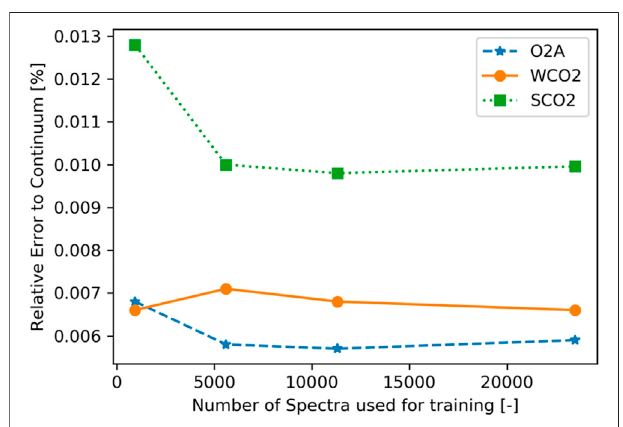
FIGURE11 | Modeling error inpercentrelative tocontinuum fordifferent training set sizes. O2A-band is shown with blue stars, WCO2-band with orange dots, and SCO2-band with green